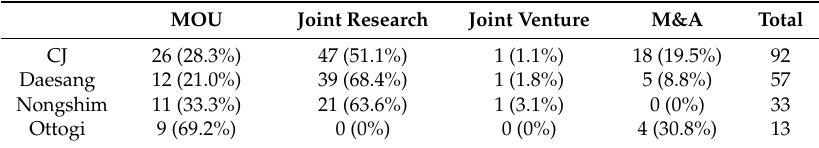
Table 4. Characteristics of alliances according to open innovation type (2008~2018, cases). MOU